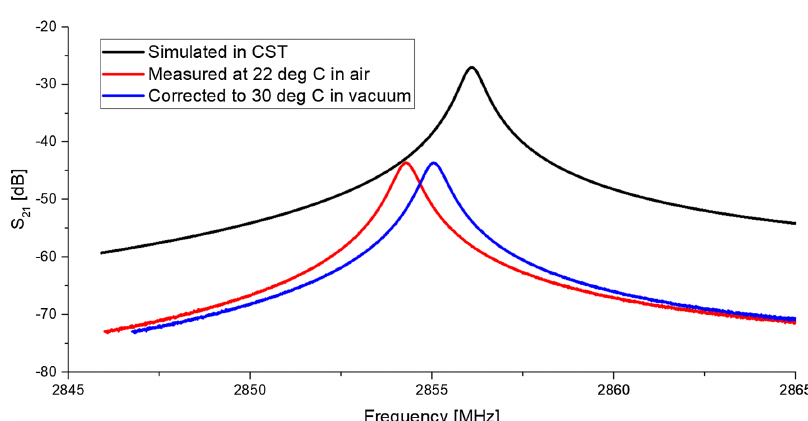
FIG. 25. Simulated (black),measured (red)andcorrected (blue) magnitudesofthepowertransmission ( S 21 ) ina singlecell